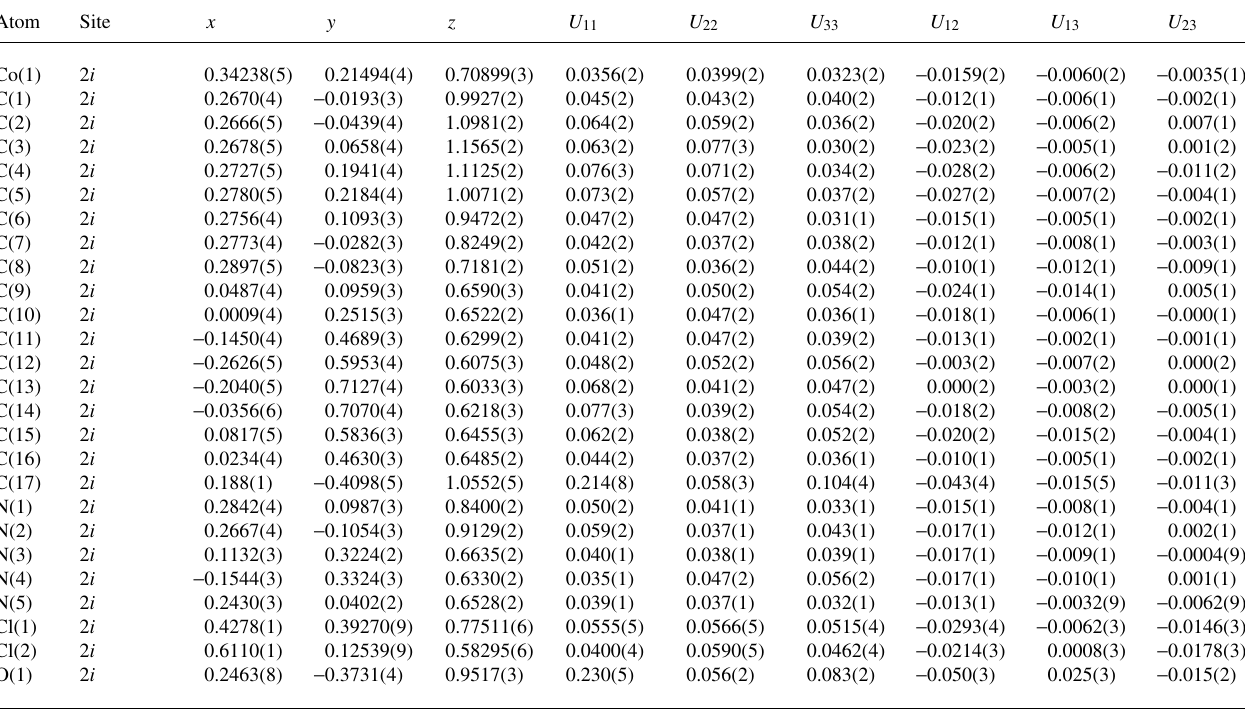
Table 3. Atomic coordinates and displacement parameters (in Å 2 )